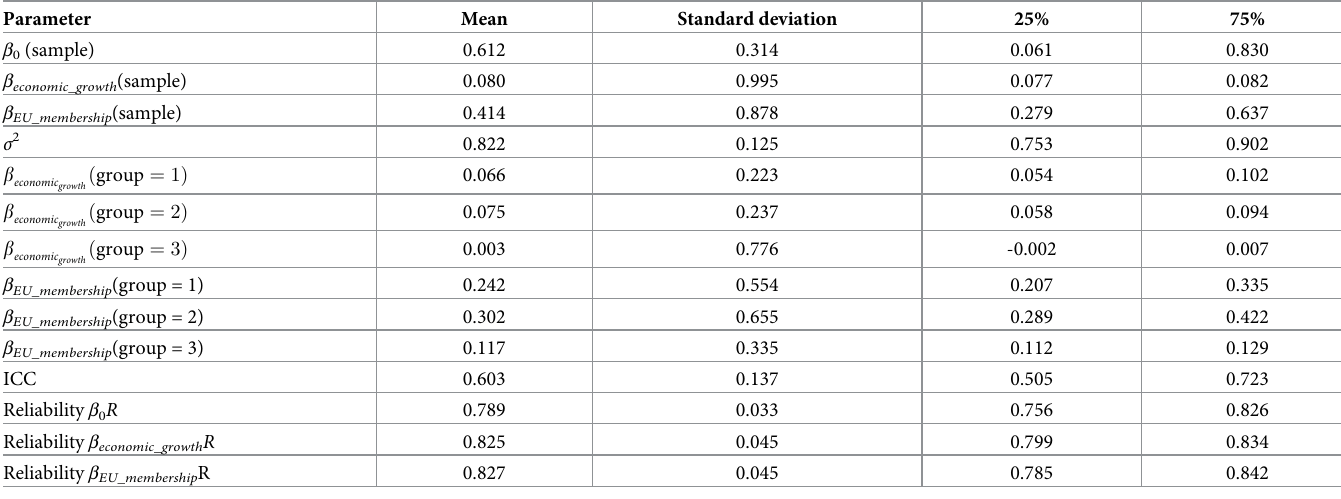
Table 8. Posterior summary statistics of